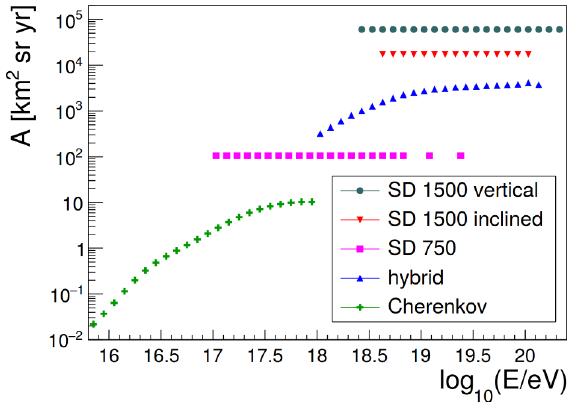
Figure 4. Ratio distribution of the Surface Detector and Fluores- cence Detector energies for three di ff erent energy ranges. Details can be found in Ref. [11].